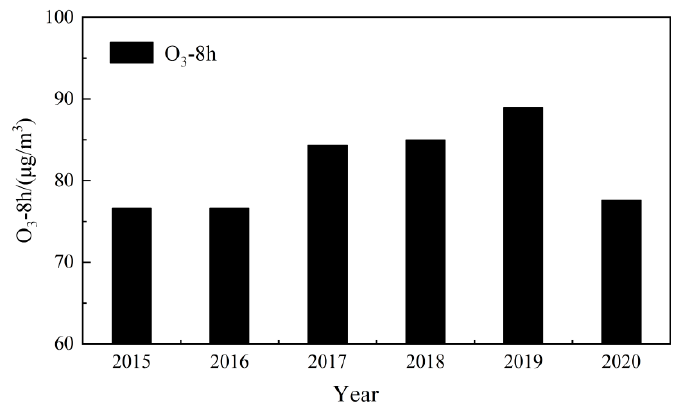
Figure 2. Variation trend of annual mean O 3 -8h in Yunnan Province from 2015 to 2020.